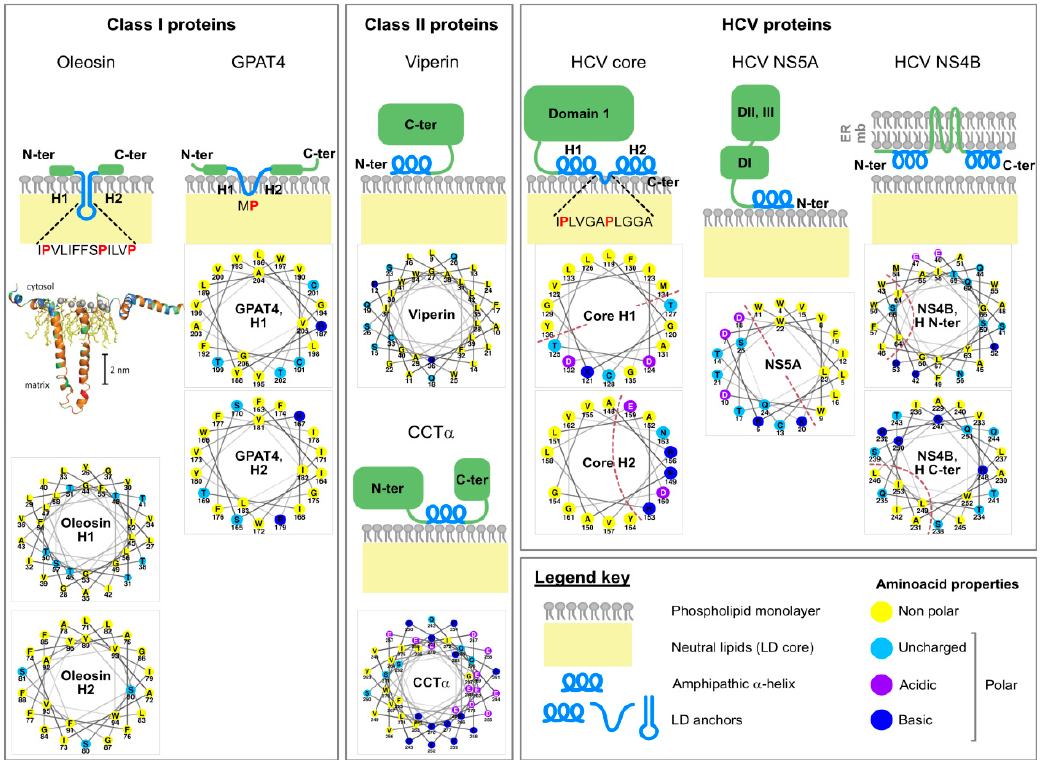
Figure 2. Different ways to bind lipid droplets. Presumed topology of representative host and viral lipid droplet-binding proteins: P. patens plant oleosin, drosophila GPAT4 [39], mouse viperin [49], human CCT α [57], HCV core (genotype 1a strain Glasgow) [45], NS5A (consensus sequence) [47], NS4B (genotype 1b strain O) [56]. Wheel representations of the predicted or confirmed α -helices were drawn with Netwheels (http://lbqp.unb.br/NetWheels/) [58]. Dashed brown lines where assigned by the authors (where relevant) and indicate the boundary between hydrophobic and hydrophilic portion of the helix. The secondary structure of oleosin represented on the lipid droplet surface was based on homology modeling and is reproduced from Huang et al. [38] with permission of the authors and of the American Society of Plant Biologists (permission obtained via Copyright Clearance Center).